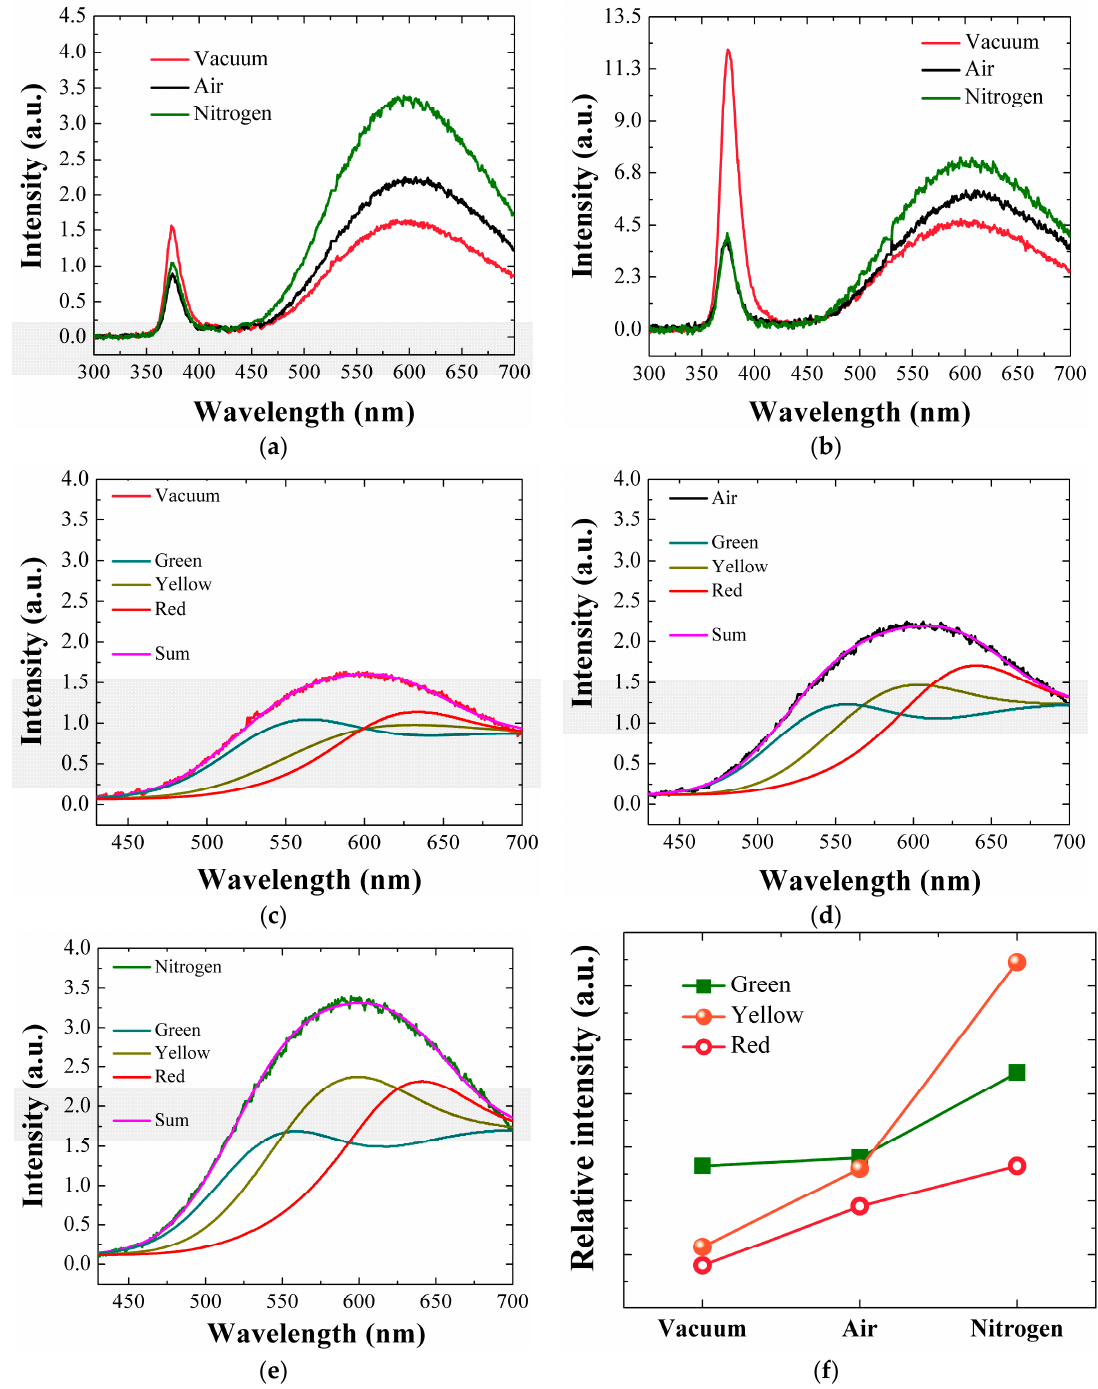
Figure 8. PL spectra for ( a ) the ZnO SLs annealed in three different ambients, and ( b ) the NRs grown on each different SL; De-convoluted visible emission spectra of the SLs annealed in ( c ) vacuum; ( d ) air, and ( e ) nitrogen ambients. Relative intensities of each de-convoluted satellite peak are shown in ( f ). Visible light emission ranging from 500 to 700 nm is the second prominent peak as observed in all PL spectra. This emission is known to be originated by deep-level emissions (DLE) caused by the recombination of photo-generated charges with various kinds of intrinsic crystal defects such as neutral or charged O/Zn vacancies, interstitials and anti-sites. The exact nature of each defect state